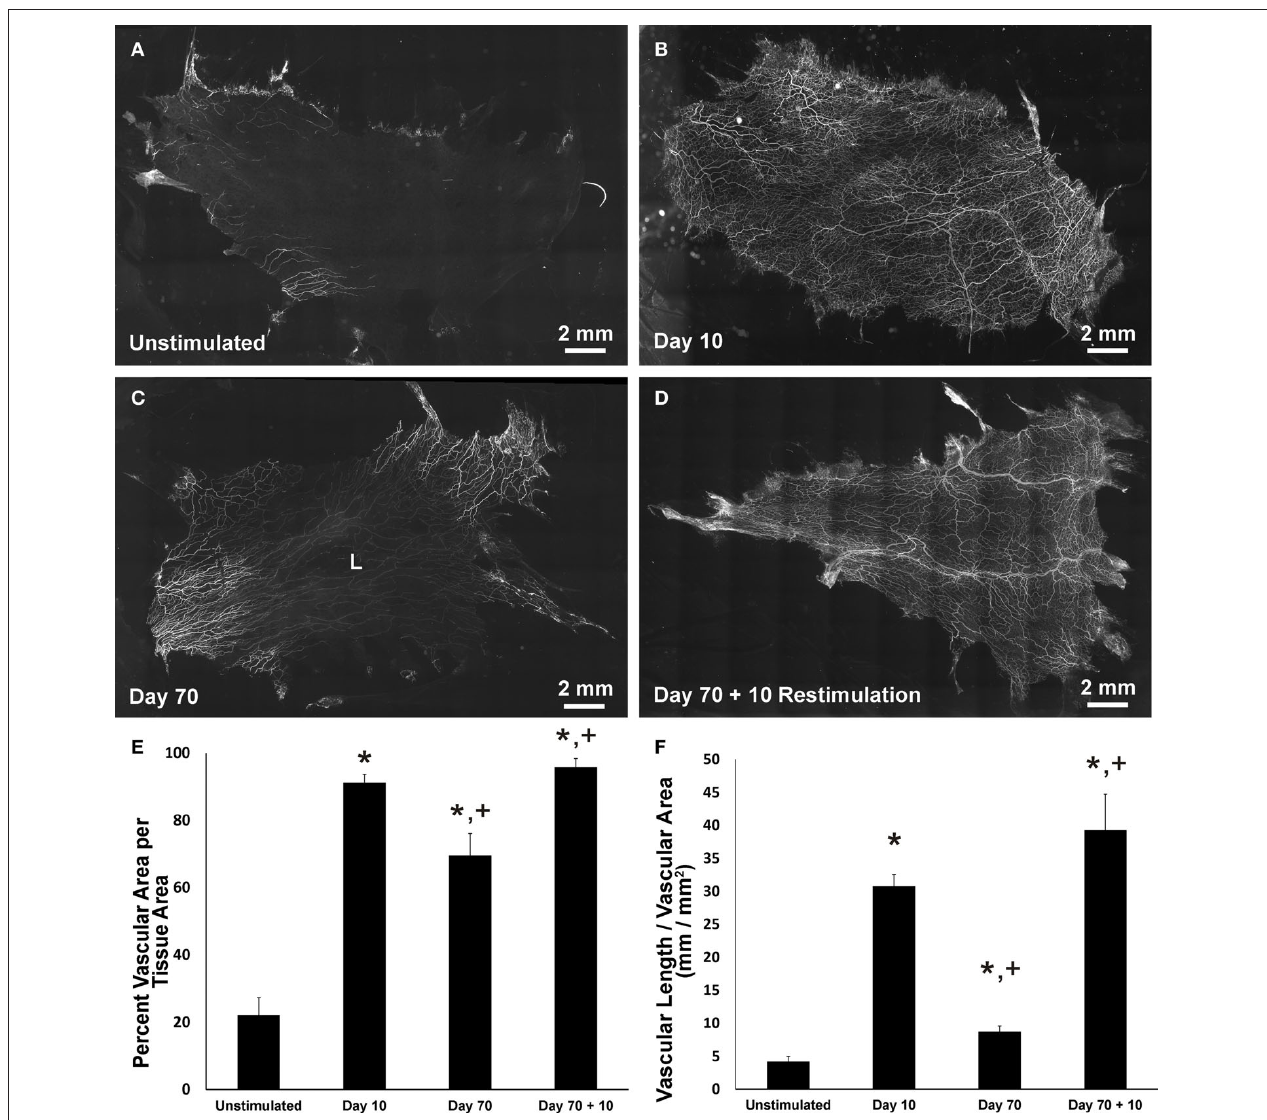
FIGURE 2 | Microvascular network area and length density changes post stimulation and restimulation. (A–D) Representative montages of PECAM-labeled mesenteric tissues from the following experimental groups: unstimulated, 10 day post stimulation, 70 day post stimulation, and 70 day post stimulation + 10 day